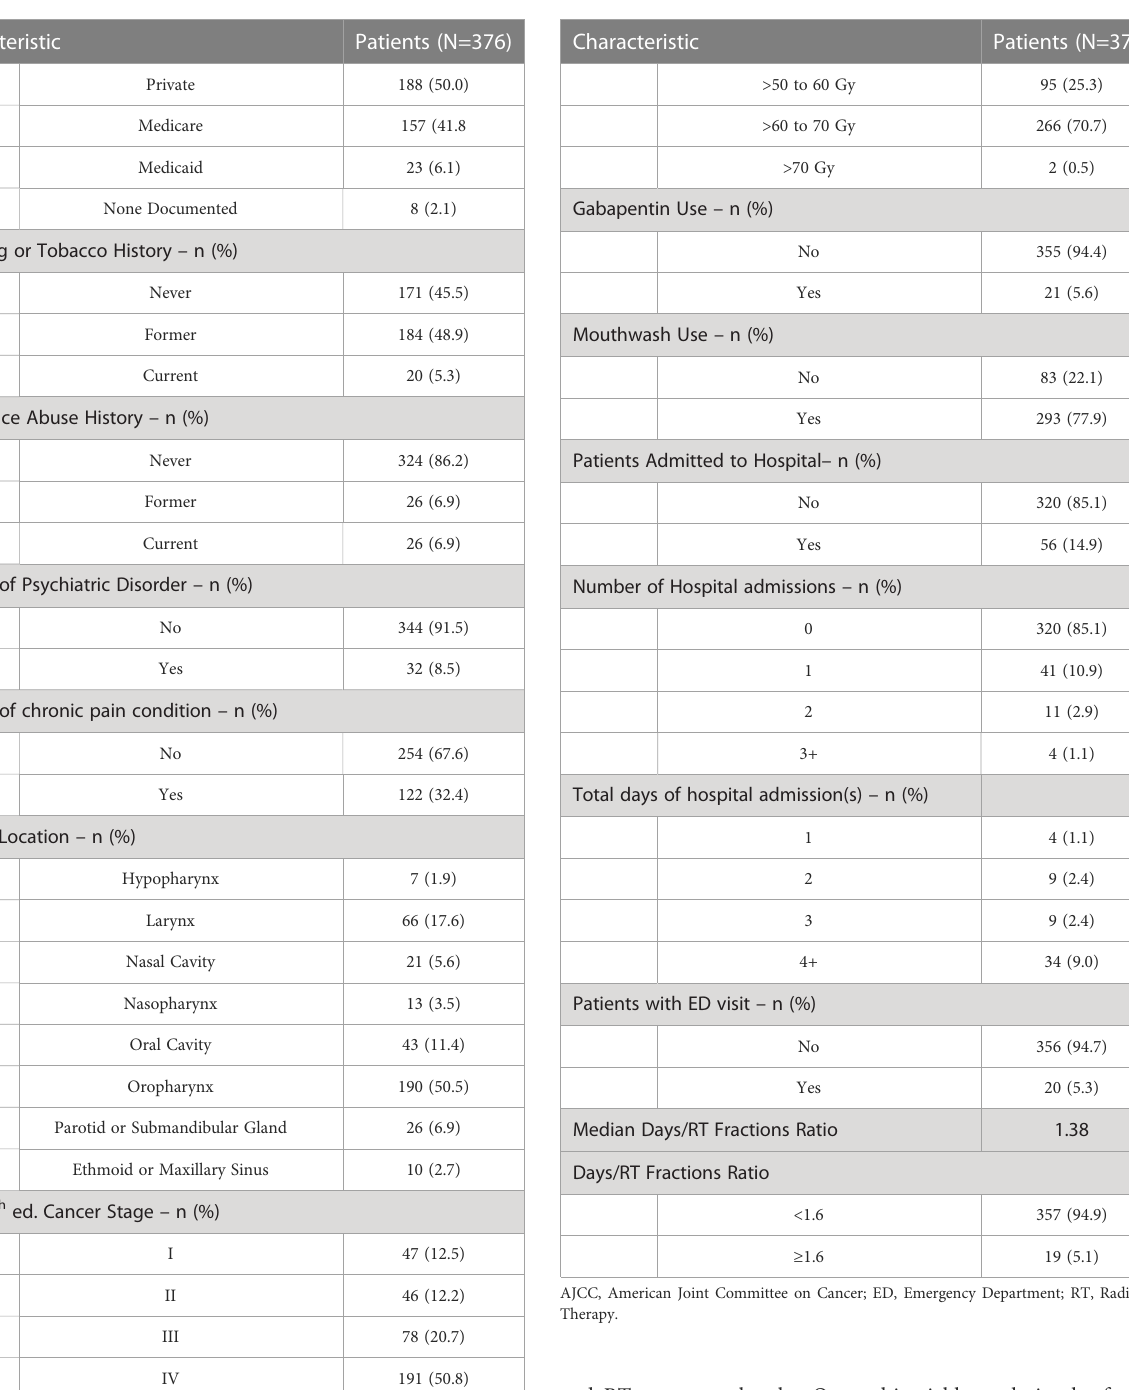
and RT treatment breaks. On multivariable analysis, the factors independently associated with ED visits during RT were heavy opioid use (OR 5.39, p<0.01) and black race (OR 6.93, p<0.01) (Table 2). Unplanned hospital admissions during RT were only independently associated with the receipt of concomitant chemotherapy (OR 9.73, p<0.01) (Table 3). Heavy opioid use was associated with hospital admissions on univariable analysis (OR 2.00, p=0.019), but this was not signi fi cant on multivariable analysis. On the multivariable analysis, older age (OR 1.08, p<0.01), lower socioeconomic class (OR 4.94, p<0.01), primary salivary tumor site (OR 5.39, p=0.04), and receipt of